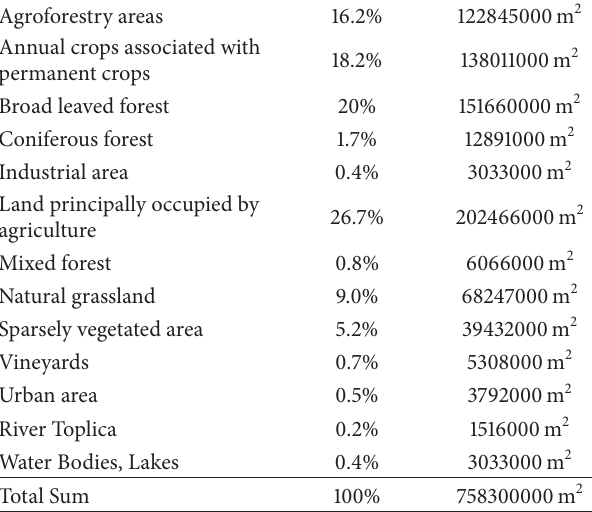
Table 4: The percentage and area of types of land on the territory of Prokuplje Municipality in m 2 in 1984.